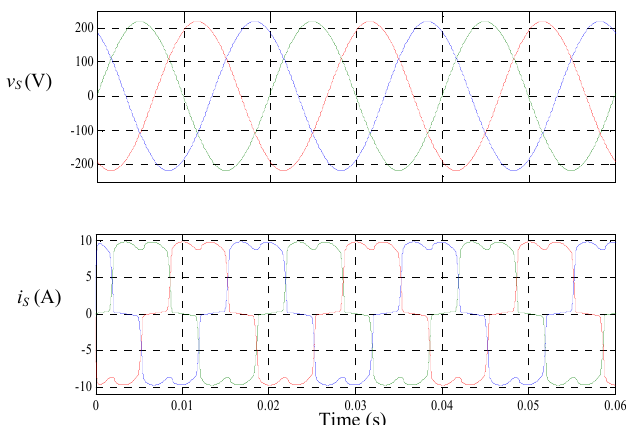
Figure 7. Sine and cosine function from the unit vector circuit.